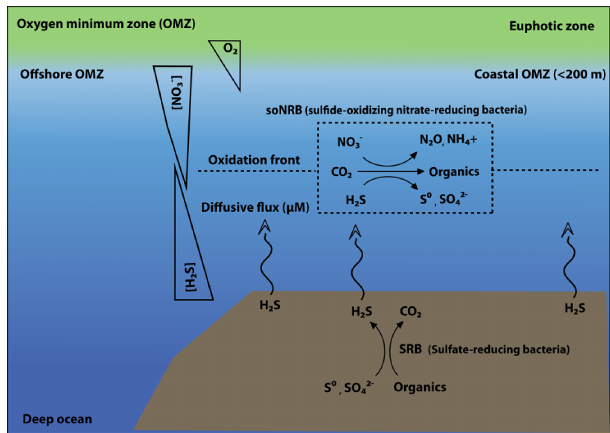
Figure 5. Schematic representation of the dynamics of a sulfidic event occurring in an oxygen minimum zone, e.g. in the ETSP. The sulfide and nitrate fluxes are shown in steady state. Sulfate-reducing bacteria produce sulfide from the sediment while the complemen- tary detoxification process occurs in the water column at overlap- ping